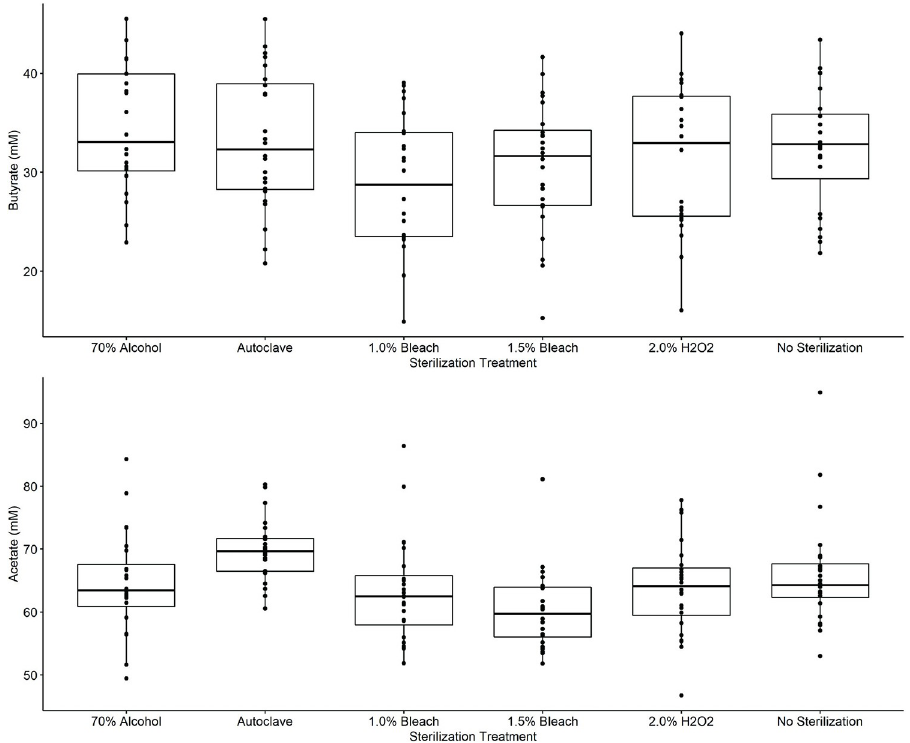
Fig 8. Comparison of (A) butyrate concentrations and (B) acetate concentrations following simulated in vitro colonic fermentations at 37˚C for 24 h on treated pulse flours with fecal inclusion in RUM media. No significant differences were found in butyrate or acetate concentrations between sterilized and unsterilized fermentations.